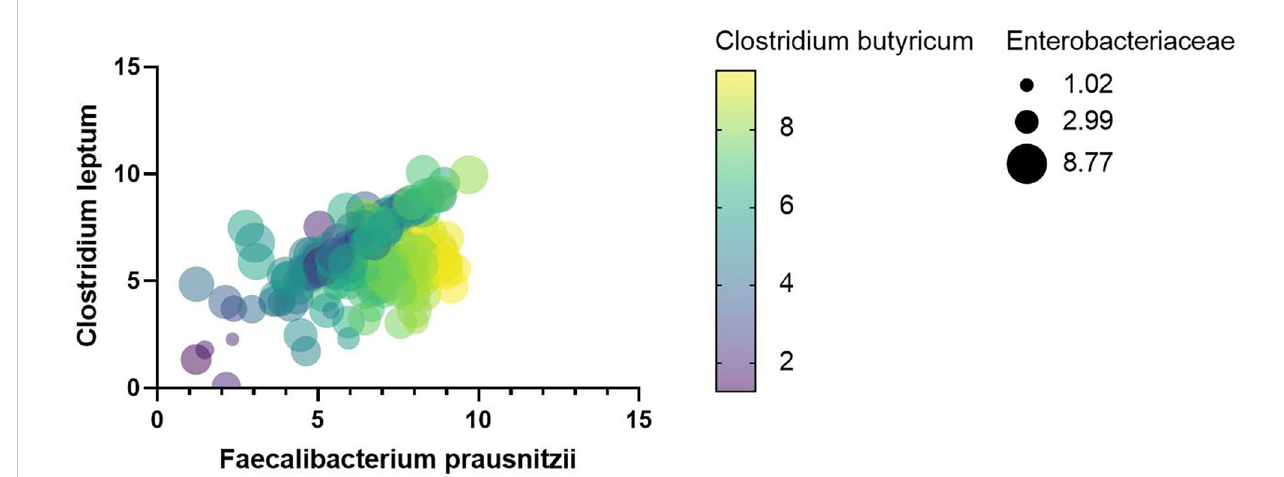
FIGURE 10 Heat map between F. prausnitzii and indicators with p -values less than 0.001 for multivariate regression